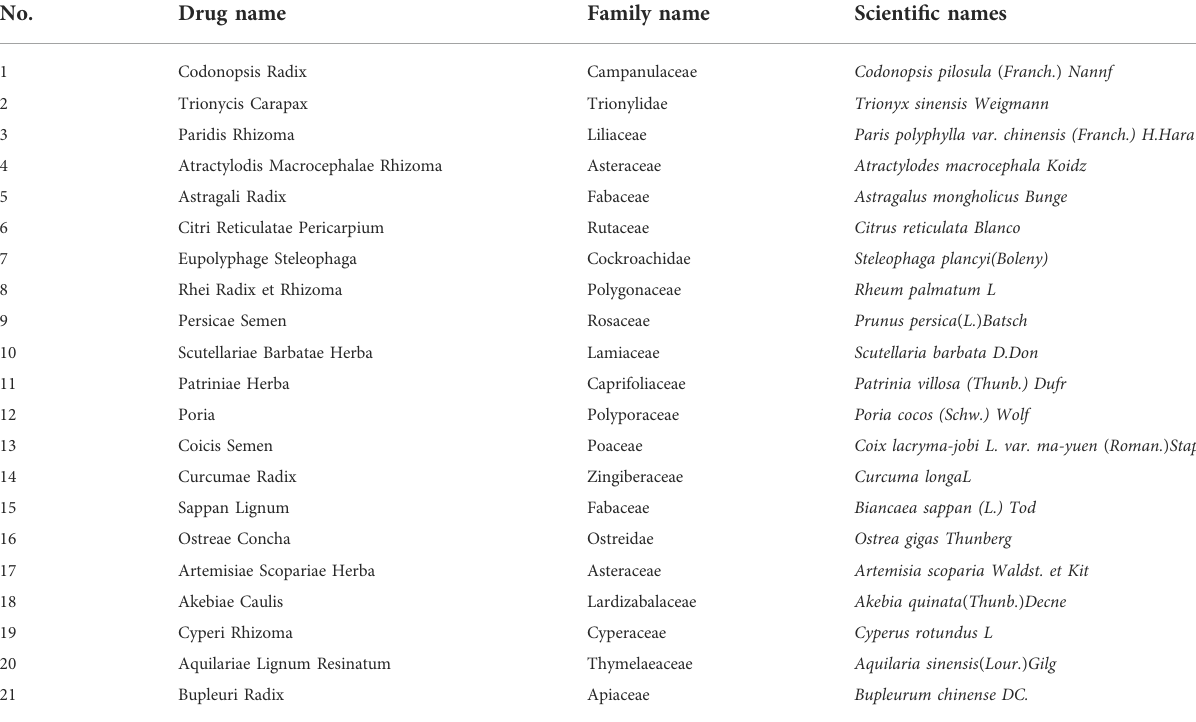
TABLE 1 Composition of GFL